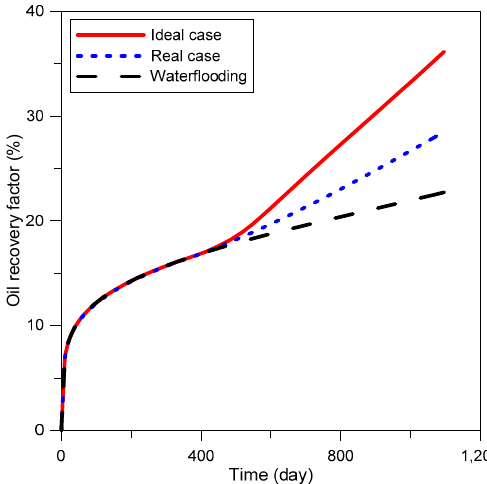
Figure 3. Oil recovery prediction results for the ideal case and real case.